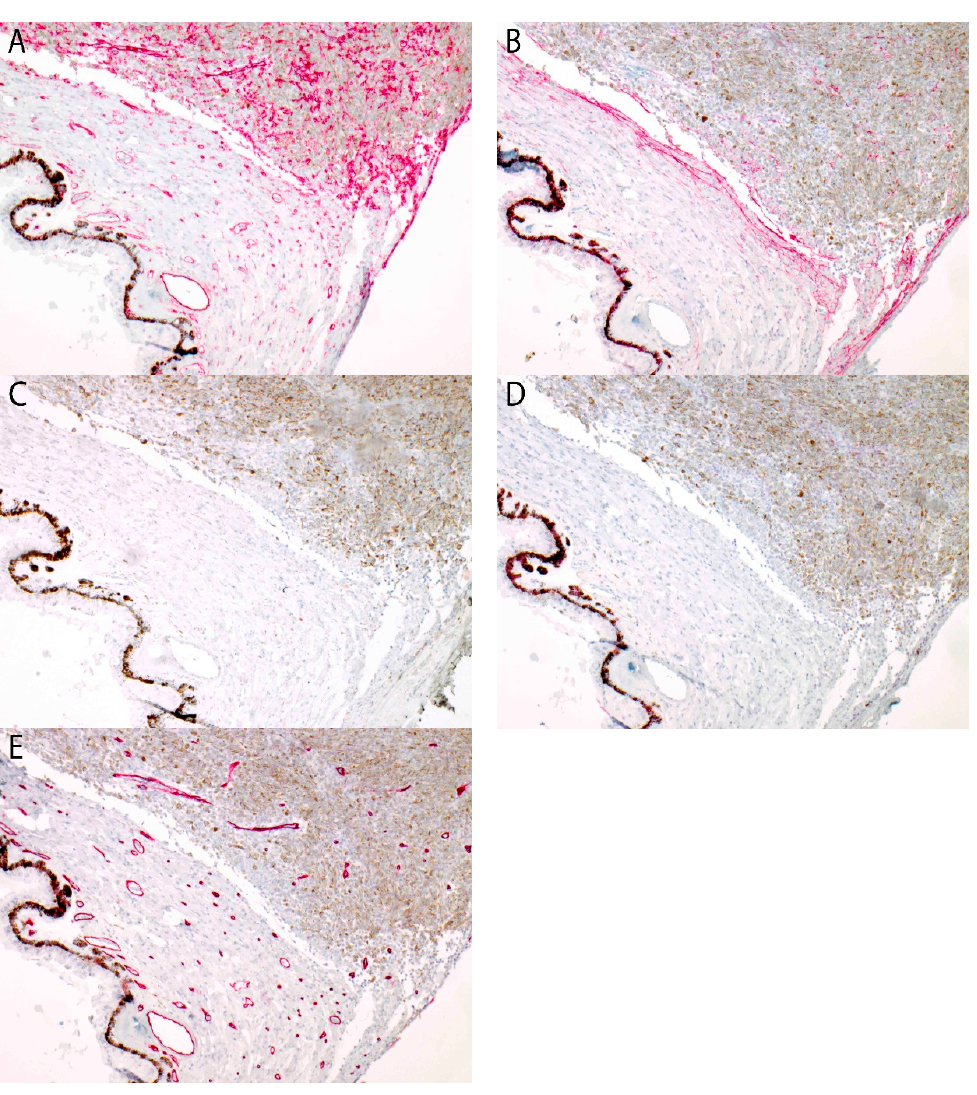
Figure A2. Positive staining of the anterior ciliary body for D2-40 in uveal melanoma. ( A ) CD31 stains all vascular endothelial cells. ( B ) D2-40 stains the peritumoral stroma of the anterior ciliary body. ( C ) LYVE-1 is negative. ( D ) Prox-1 is negative. ( E ) CD34 stains all vascular endothelial cells. (All panels: original magnification 50×).